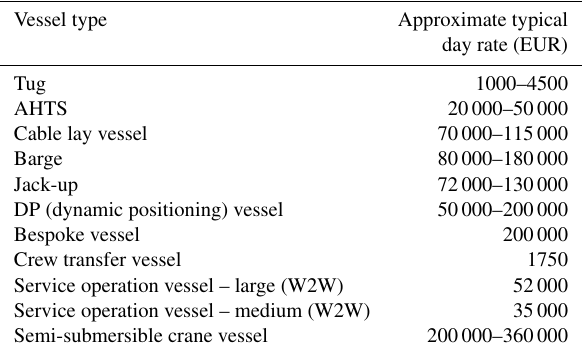
Table 4. Day rates of different types of vessels used in the FOW industry (Jiang, 2021; Sperstad et al., 2017; Foxwell, 2019). Vessel